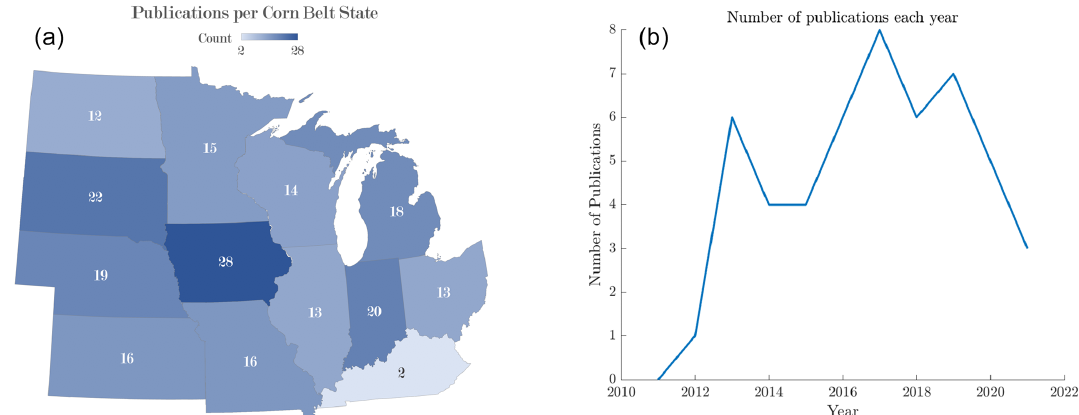
Figure 4. (a) States in the Corn Belt color-coded by the number of documents that included that state in their study area. (b) Number of publications per year.